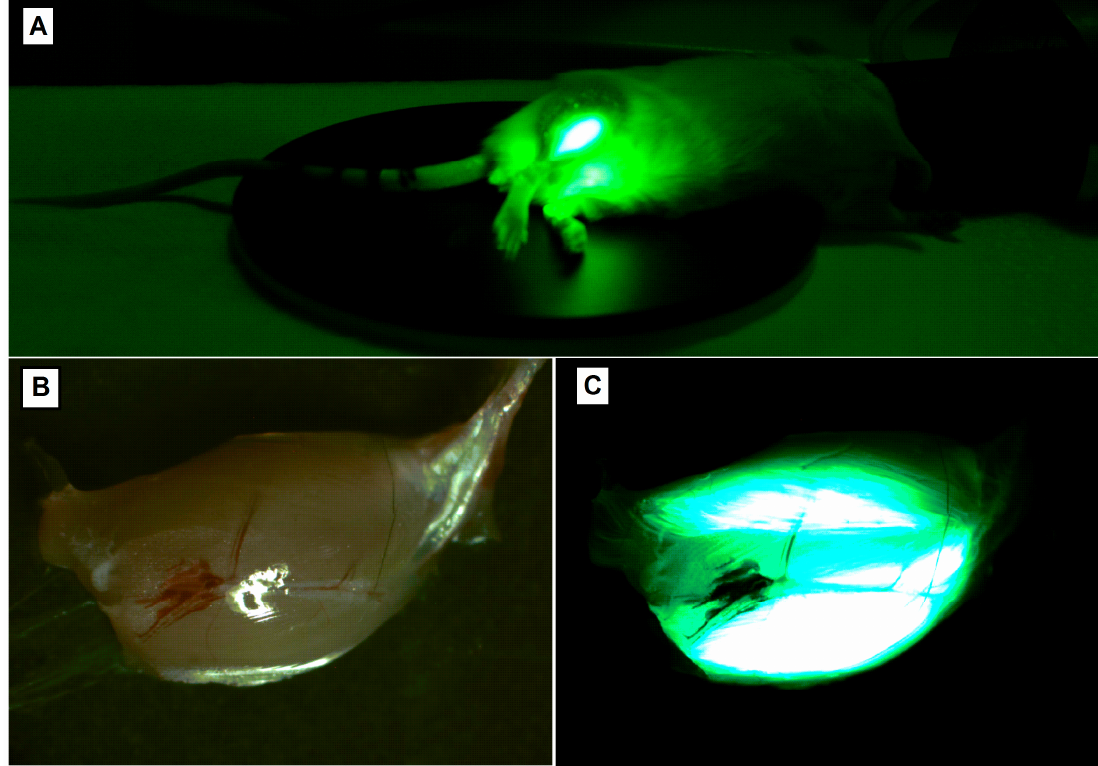
Figure 4. The photographs made by our research team show the bioluminescence of GFP as a reporter protein 3 days after electroporation ( A ) of tibialis muscle in vivo in a living mouse and ( C ) ex vivo in gastrocnemius muscle. The green fluorescence of muscle fibres can be observed through the skin on the same animal by means of time-lapse fluorescence imaging ( A ). GFP emits green light following excitation by wavelength in the UV range. ( B ) shows muscle viewed in the range of visible light.